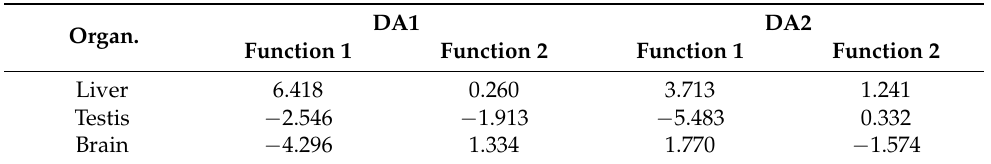
Table 2. Functions at group centroids (mean discriminant scores for each organ) of discriminant anal- ysis 1 (DA1, Figure 7) and DA2 (Figure 8) describing antioxidants and the lipid profile, respectively. Organ.